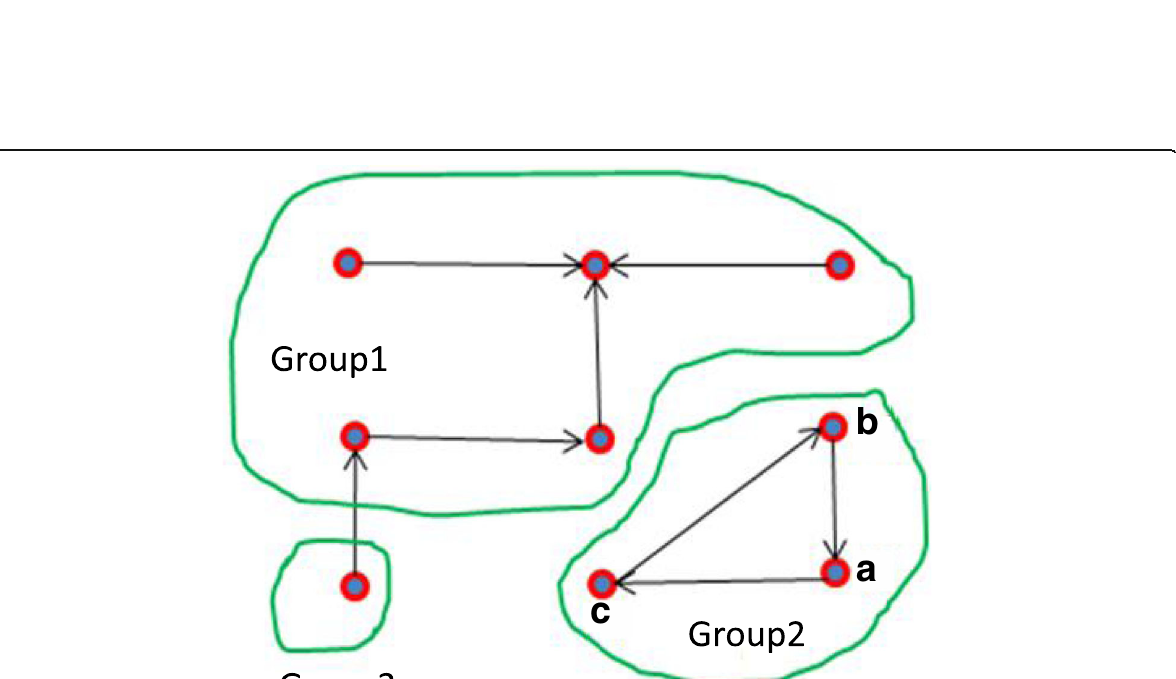
Fig. 6 An intercluster interference graph